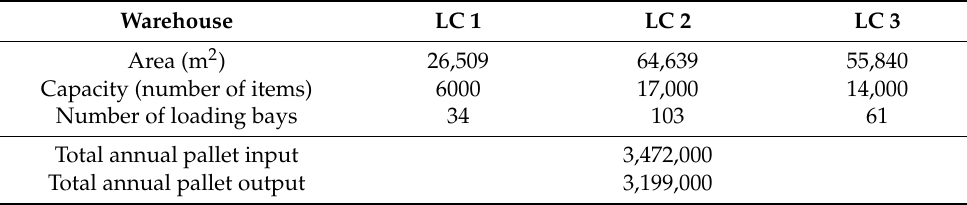
Table 1. Characteristics of individual logistics centre warehouses.